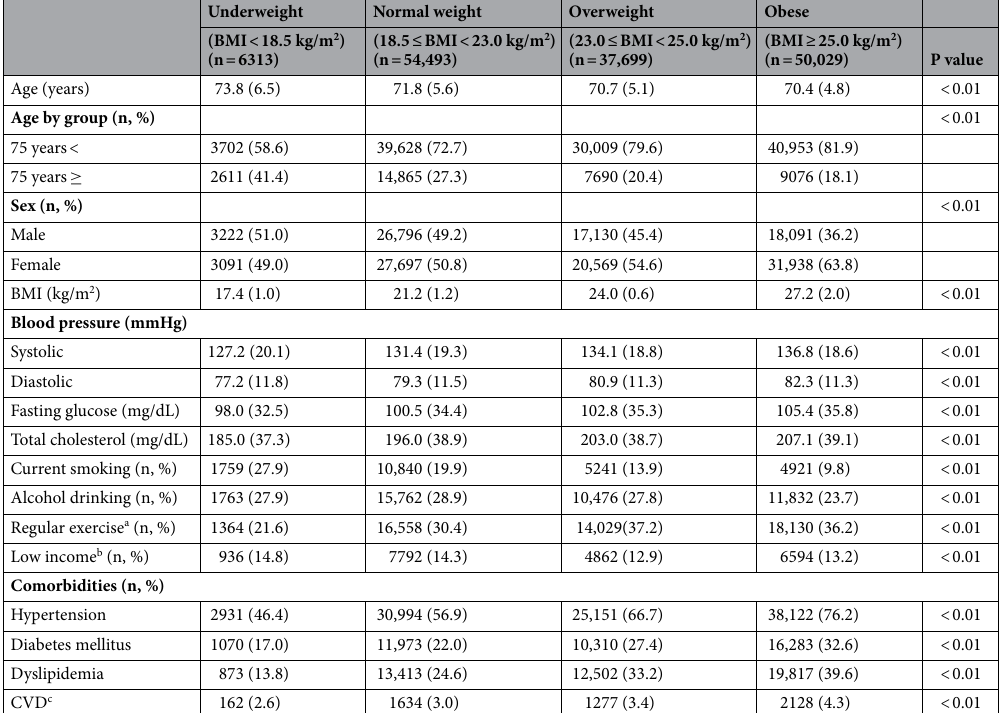
Table 1. Baseline characteristics of the study population. Data are presented as the mean (SD) and number (%). BMI, body mass index; CVD, cardiovascular disease. a Regular exerciser was defined as individuals who exercised at least once per week. b Low income was defined as medical beneficiaries and the lowest decile of health insurance premiums. c CVD was defined as answers to the self-report questionnaire in which heart disease was previously diagnosed by a physician or was being treated.